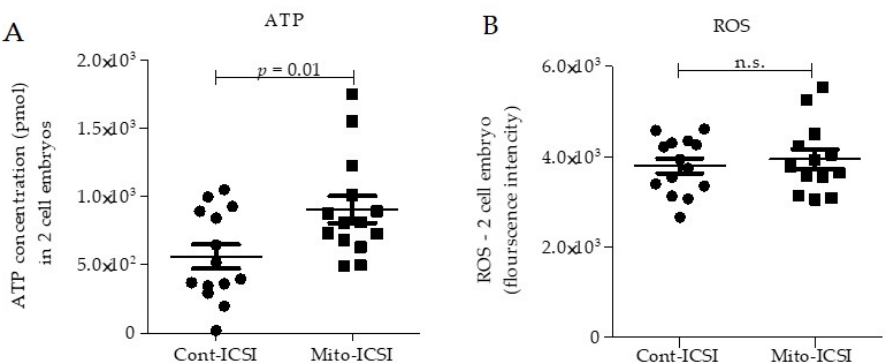
Figure 5. Mitochondria supplementation enhances the ATP production capacity in 2cell embryos. ( A ). ATP level in 2-cell embryos in the mitochondria supplemented group was significantly higher compared to the control group. ( B ). The ROS level was comparable in both groups. Data in the graphs were represented as mean ± SD.